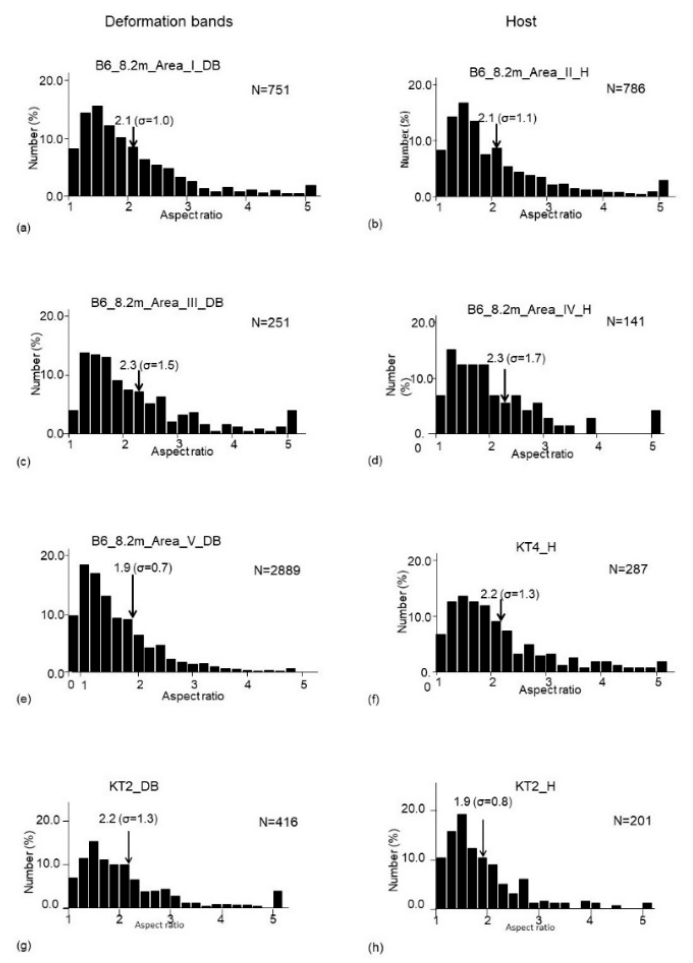
Figure 12. The histogram of aspect ratio for the ( a , c , e , g ) four deformation bands and ( b , d , f , h ) four host areas in the core and outcrop samples. Sample name is shown at the top of each diagram. The average value and one standard deviation ( σ ) are also shown.